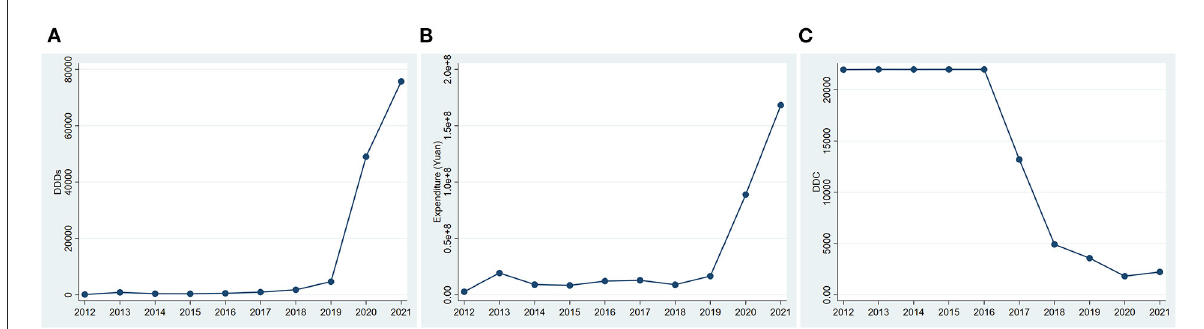
FIGURE1 Consumption of anti-HER2 drugs in Nanjing from 2012 to 2021. (A) DDDs of anti-HER2 drugs; (B) Expenditure of anti-HER2 drugs. (C) DDC of anti-HER2 drugs. DDDs, defined daily doses; DDC, defined daily cost.